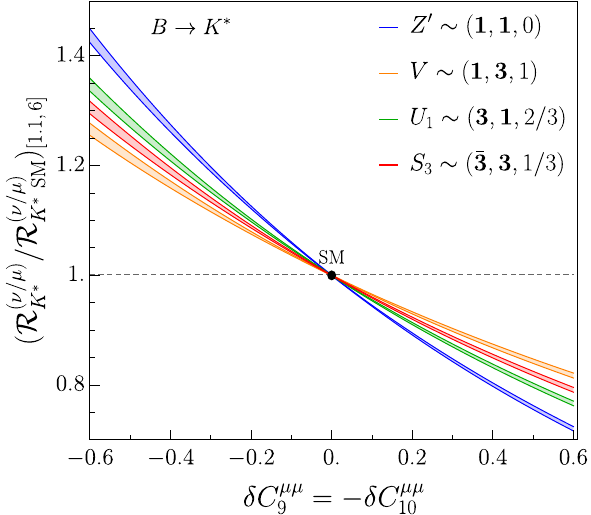
(ν/ e ) (ν/μ) (bottom and top left panels) and R (bot- K ( ∗ ) K ( ∗ ) μμ = − δ C μμ for selected 9 10